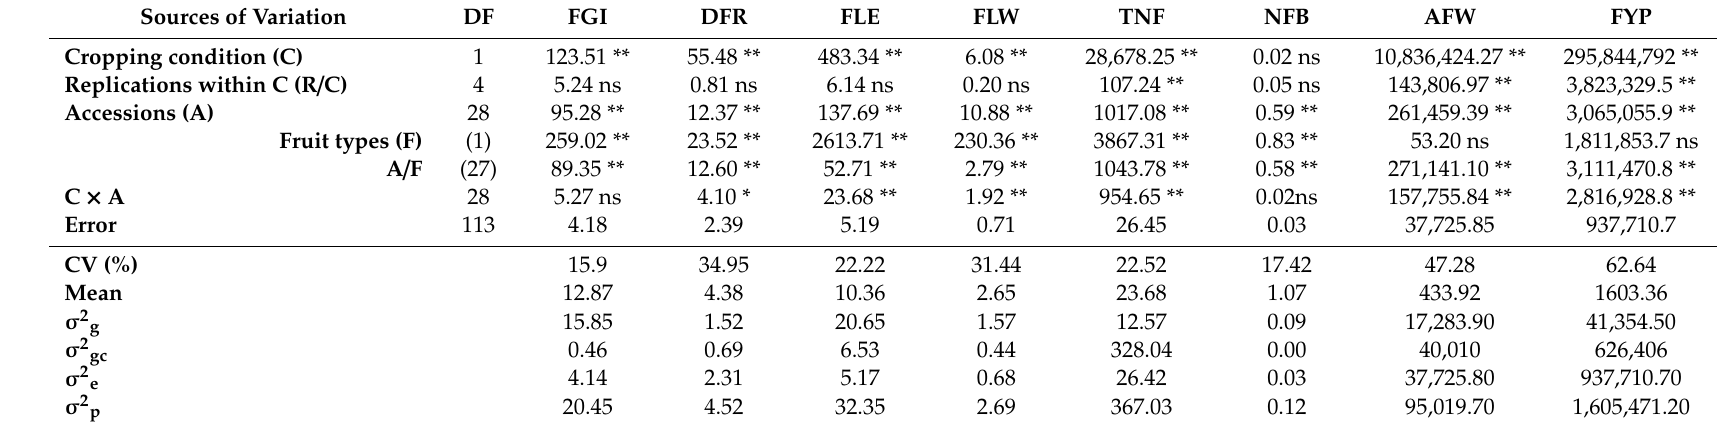
Table 2. Mean square of yield and yield component of 29 eggplant